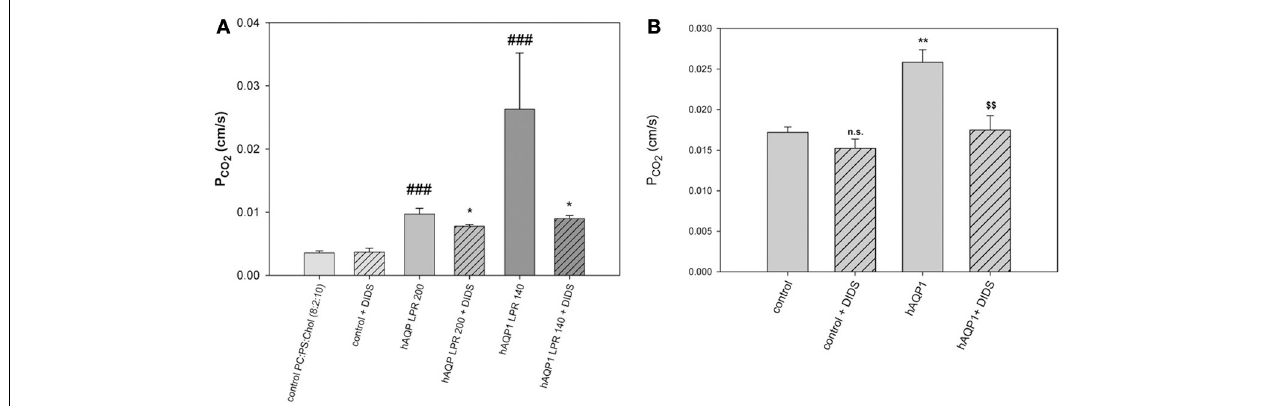
FIGURE 7 | Effects of AQP1 incorporation into lipid vesicles and into MDCK cell membranes. (A) Phospholipid vesicles of phosphatidylcholine:phosphatidylserine 8:2, with 50 mol% cholesterol, with and without incorporation of human AQP1. LPR is lipid-to-protein ratio. At the highest protein incorporation, LPR 140, the P CO measured by 18 O exchange mass spectrometry is 9-fold increased over the control (leftmost column). DIDS reduces the AQP1-mediated CO